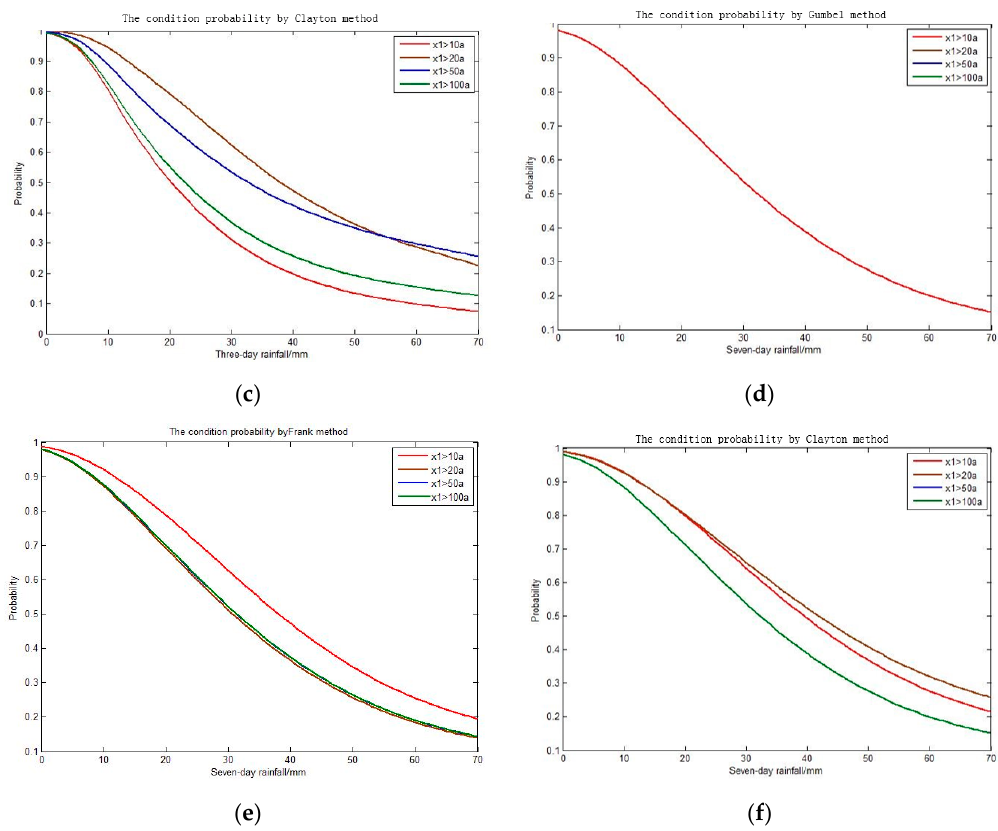
Figure 6. Frequency curves of the conditional probabilities. ( a ) one-day and three-day using Gumbel; ( b ) one-day and three-day using Frank; ( c ) one-day and three-day using Clayton; ( d ) one-day and seven-day using Gumbel; ( e ) one-day and seven-day using Frank; ( f ) one-day and seven-day using Clayton.